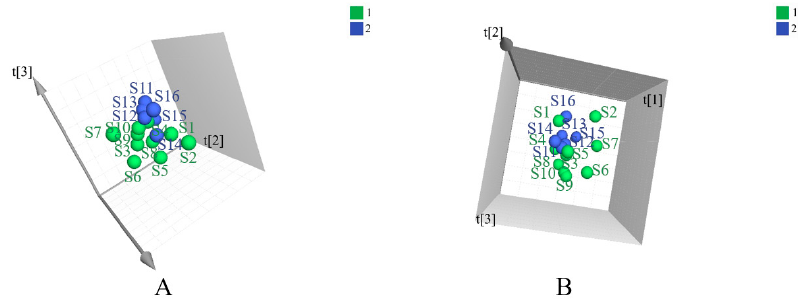
Figure 1. The PCA figures of two groups of S. tetrandra samples using UHPLC-Q-TOF-MS/MS analysis in the positive ( A ) and negative ( B ) ion models. (1: non-authentic origins; 2: geo-authentic origins).